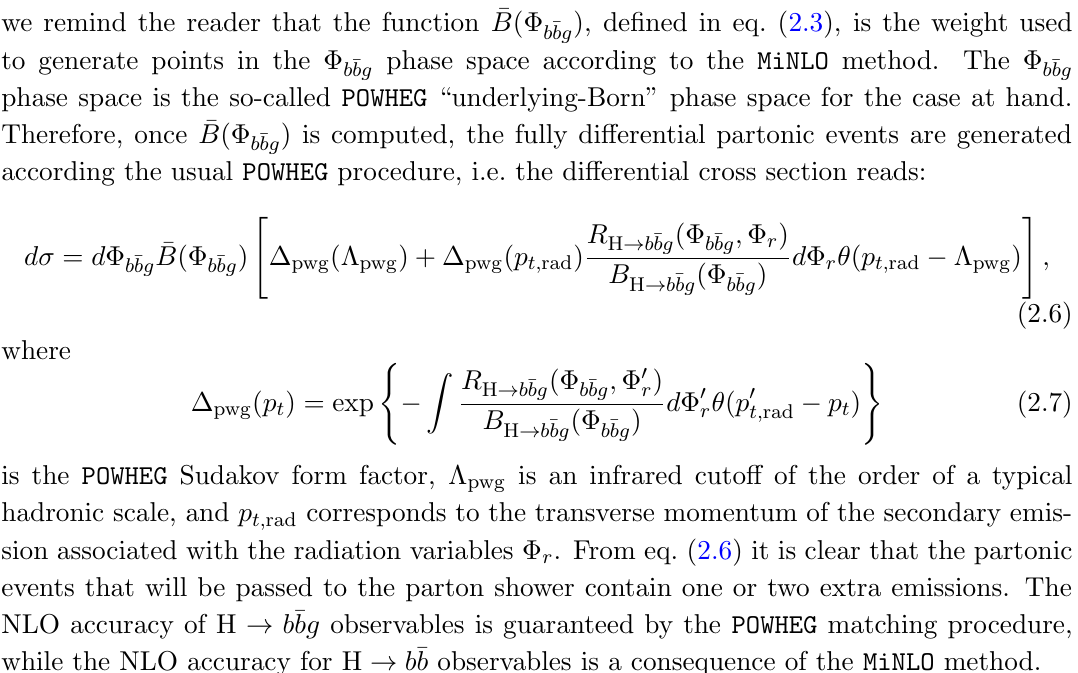
, rather than increasing as 1 = p (cid:11) s terms are present in (cid:0) MiNLO s